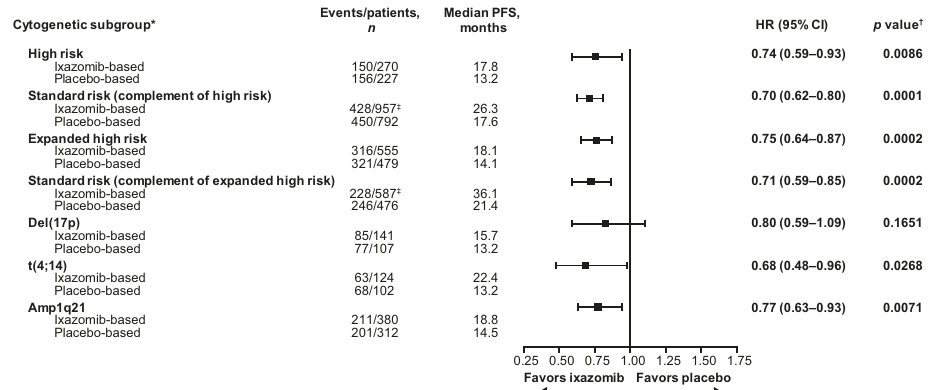
Fig. 1 Forest plot of PFS by cytogenetic subgroup for patients receiving ixazomib- vs placebo-based therapy. High-risk subgroup: presence of one or more of del(17p), t(4;14) or t(14;16) cytogenetic abnormalities; expanded high-risk subgroup: presence of any of the above and/or amp1q21; complementary standard-risk subgroups: patients without any of the speci fi ed cytogenetic abnormalities listed above for high-risk and expanded high-risk. *Data for t(14;16) are not shown due to small patient numbers. † Descriptive p values; analyses not powered for statistical testing. ‡ 1 patient was not included in the analysis due to inadequate sampling for cytogenetic assessment. CI con fi dence interval, HR hazard ratio, PFS progression-free survival.